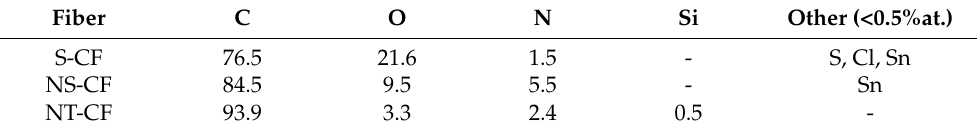
Table 8. Atomic composition of the carbon fibers surfaces.